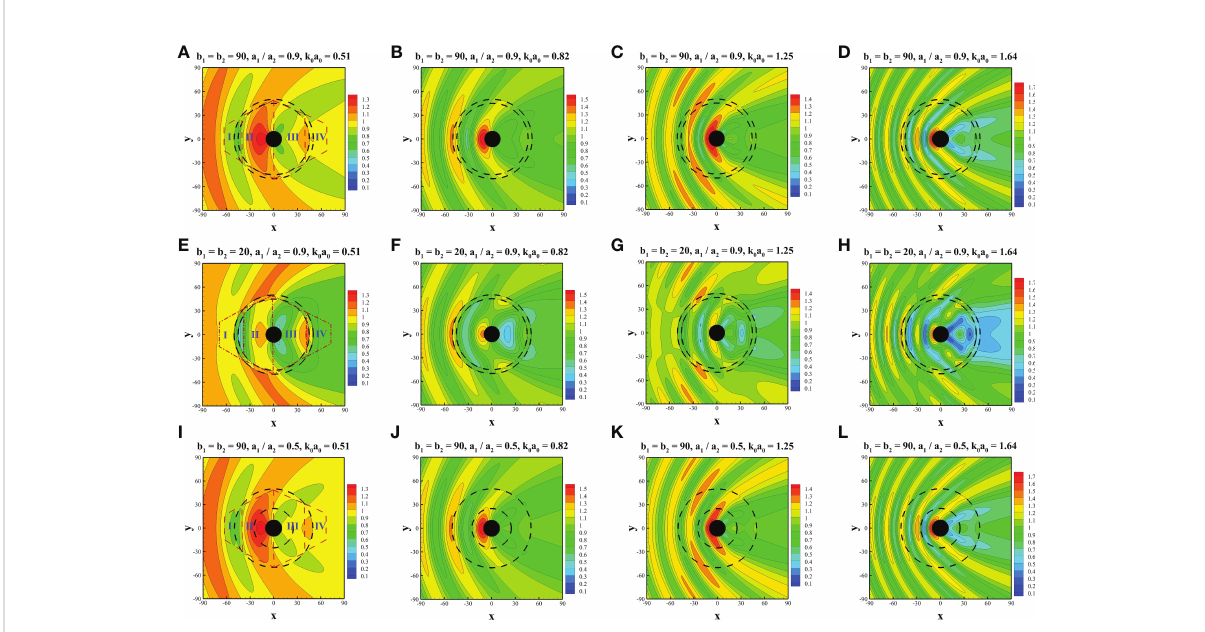
FIGURE 8 Comparison of wave fi eld at various wavenumbers. (A – D) b 1 = b 2 = 90, a 1 / a 2 = 0.9, (E – H) b 1 = b 2 = 20, a 1 / a 2 = 0.9, and (I – L) b 1 = b 2 = 90, a 1 / a 2 =